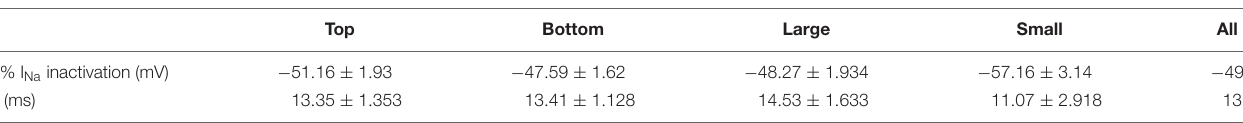
FIGURE 4 | The voltage-gated I Na in OB DA neurons. All recordings were performed in the presence of Cs and Cd. (A) Example of a group of I Na from a DA neuron. These currents were activated by progressively depolarizing 200-ms 10 mV voltage steps, from –10 to 80 mV. Capacitance artifacts were manually blanked. (B) The current-voltage relationship (derived from 11 neurons) showing peaks of I Na . The largest peak amplitudes were produced when the membrane was depolarized between –20 and 0 mV. (C) An example of the protocol used to derive the inactivation/h ∞ curve in panel (E) . 50 ms pre-pulse voltage steps ranged from –90 to –30 mV in 10 mV steps. Test 100 ms test pulse was 80 mV. Each color of the protocol trace is coordinated with the color of the current trace. (D) An example of the protocol used to derive the removal of inactivation/IPI curve in H. Neurons received paired voltage steps, depolarizing the membrane to 60 mV, with increasing subsequent IPIs (0.5, 1, 3, 5, 7.5, 10, 12.5, 15, and 50 ms). (E) The I Na h ∞ inactivation curve (derived from 23 neurons). Half of I Na is inactive when the membrane is depolarized to –49 mV. (F) To gauge if I Na inactivation properties differ between DA neurons based on their glomerular localization and/or neuronal area, their membrane voltages at 50% inactivation were compared. There was no significant difference between neurons based on localization ( n = 23, p = 0.2149, Fi ) or area ( n = 13, p = 0.4645, Fii ). (G) Inactivation curves were also compared between Top and Bottom (Gi) and Large and Small (Gii) neurons. For the membrane potentials of –70 and –60 mV, there were no significant differences between Top and Bottom neurons (–70 mV: n = 23, p = 0.1500; –60 mV: n = 23, p = 0.067), while there were significant differences between Large and Small neurons (–70 mV: n = 13, p = 0.0032**; –60 mV: n = 13, p = 0.0258*). (H) The I Na IPI curve (derived from 25 neurons). Currents were activated with two 60-mV, 20-ms depolarizing steps. The activation time constant ( τ = 63% of the channels are activated) is 13 ms. (I) To gauge if I Na reactivation properties differ between DA neurons based on their glomerular localization and/or neuronal area, the average τ were compared. There was no significant difference between neurons based on localization ( n = 25, p = 0.9710, Ii ) or area ( n = 12, p = 0.2913, Iii ). (J) Individual IPI curves were also constructed for Top and Bottom (Ji) and Large and Small (Jii) DA neurons. These two sets of curves were similar. Data points are represented as mean ± SEM.